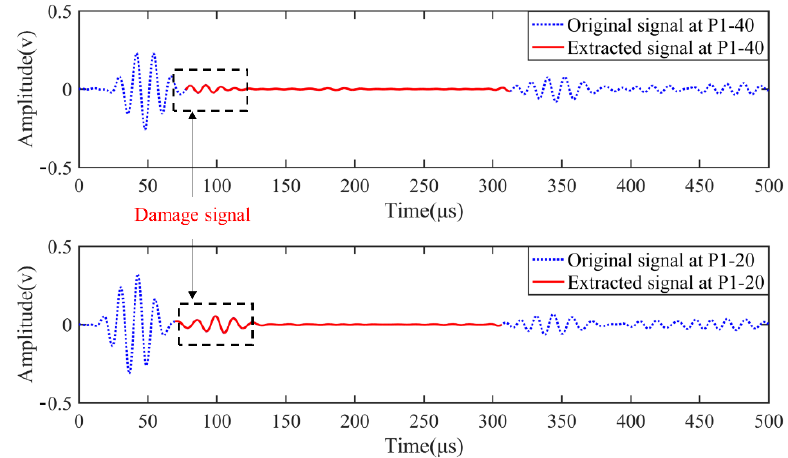
Figure 9. Comparison of extracted signals at P1-40 and P1-20 excited under identical conditions. The images of the damage generated with selected sensing points and corresponding actuators through the delay-and-sum imaging method are listed below. The involved signals were excited at the fre- quencies of 50, 80, and 120 kHz (Figure 10a–c). Figure 10d shows the imaging result with signals excited at 50 kHz and received in the surface-bonded PZTs without utilizing a mobile transducer. As shown in Figure 10a–c, the defect was located and imaged accurately compared with the real notch on the aluminum plate, apart from the discrepancy of defect size induced by the wavelength imparity. Since the PZTs were firmly attached on the surface at a fixed location, scattered signals containing damage information were inevitably missed due to the lack of proper wave propagation path, thus, leading to the absence of defect image in the detection region (Figure 10d).